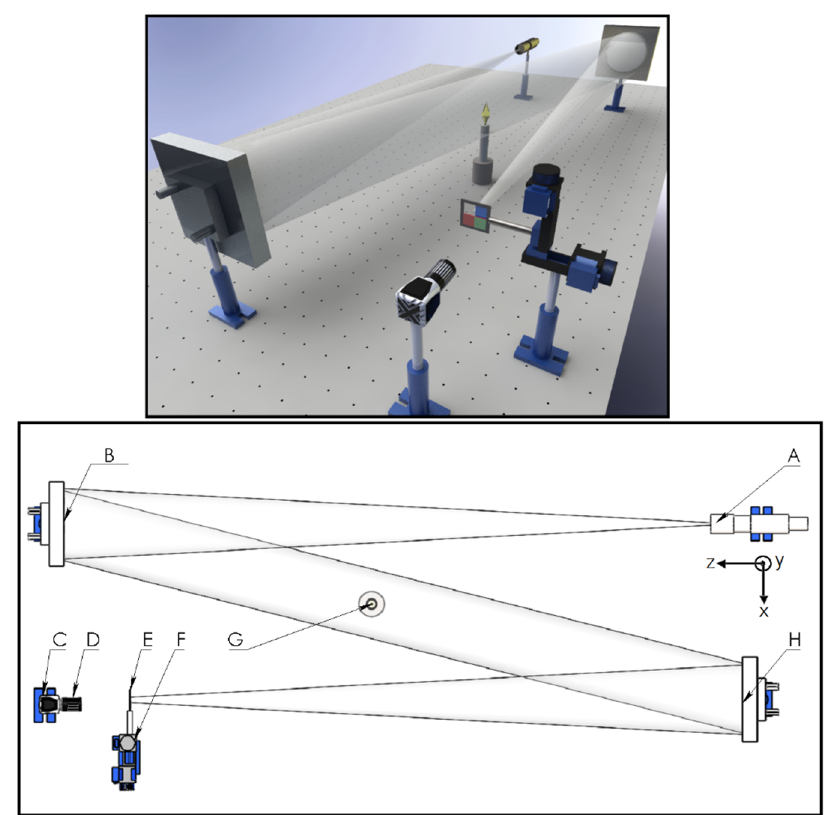
Figure 1. Scheme of horizontal-vertical sensitivity Schlieren system and shadowgraph. A— rgb LED, BH—Mirrors, C—Camera, D—Lens 50mm, E—Shortpass and longpass filters, F—Motorized translation stage, G—Sample test.